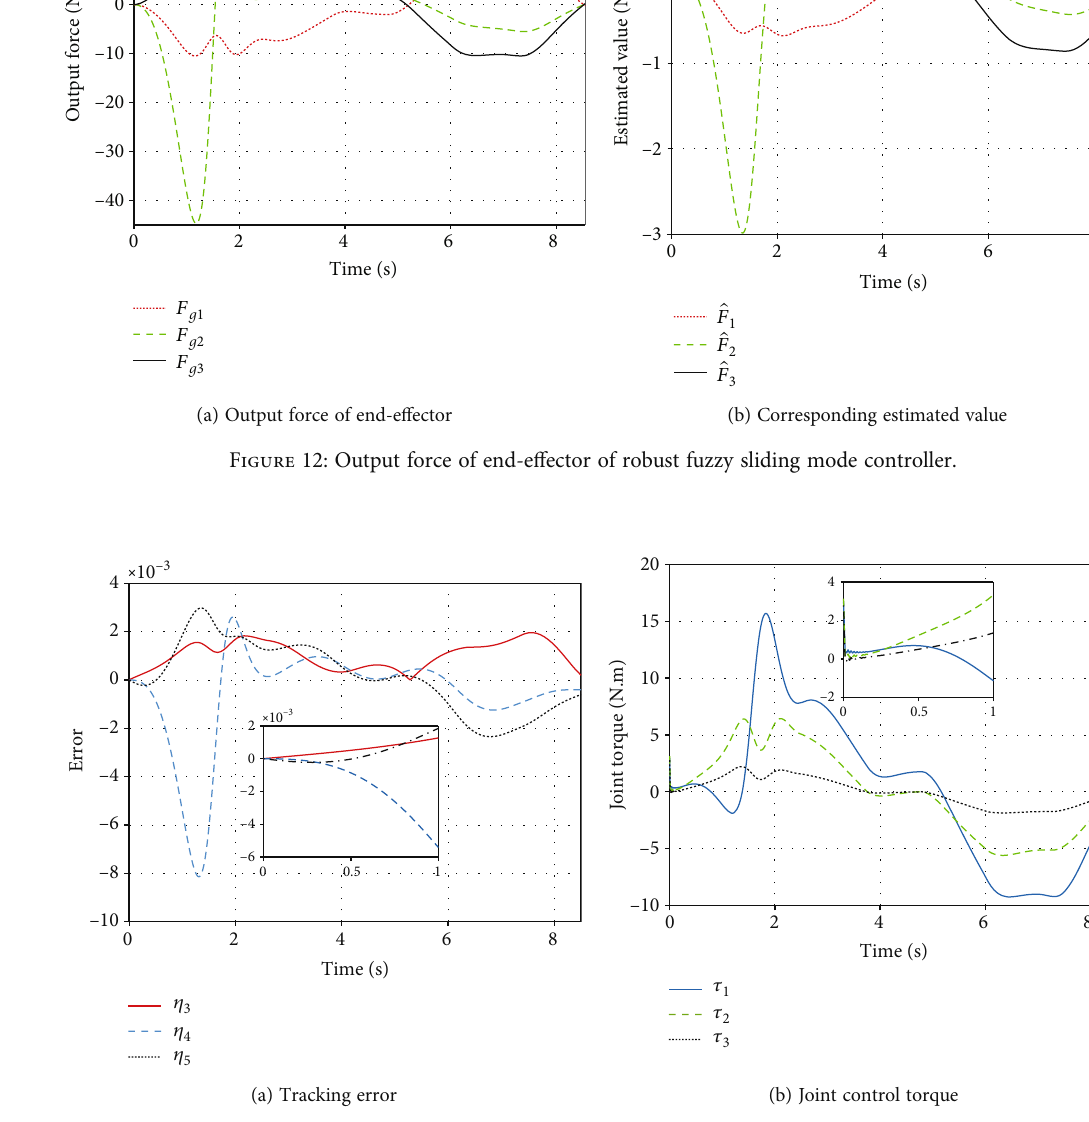
Figure 13: Simulation results of robust fuzzy sliding mode controller with interference